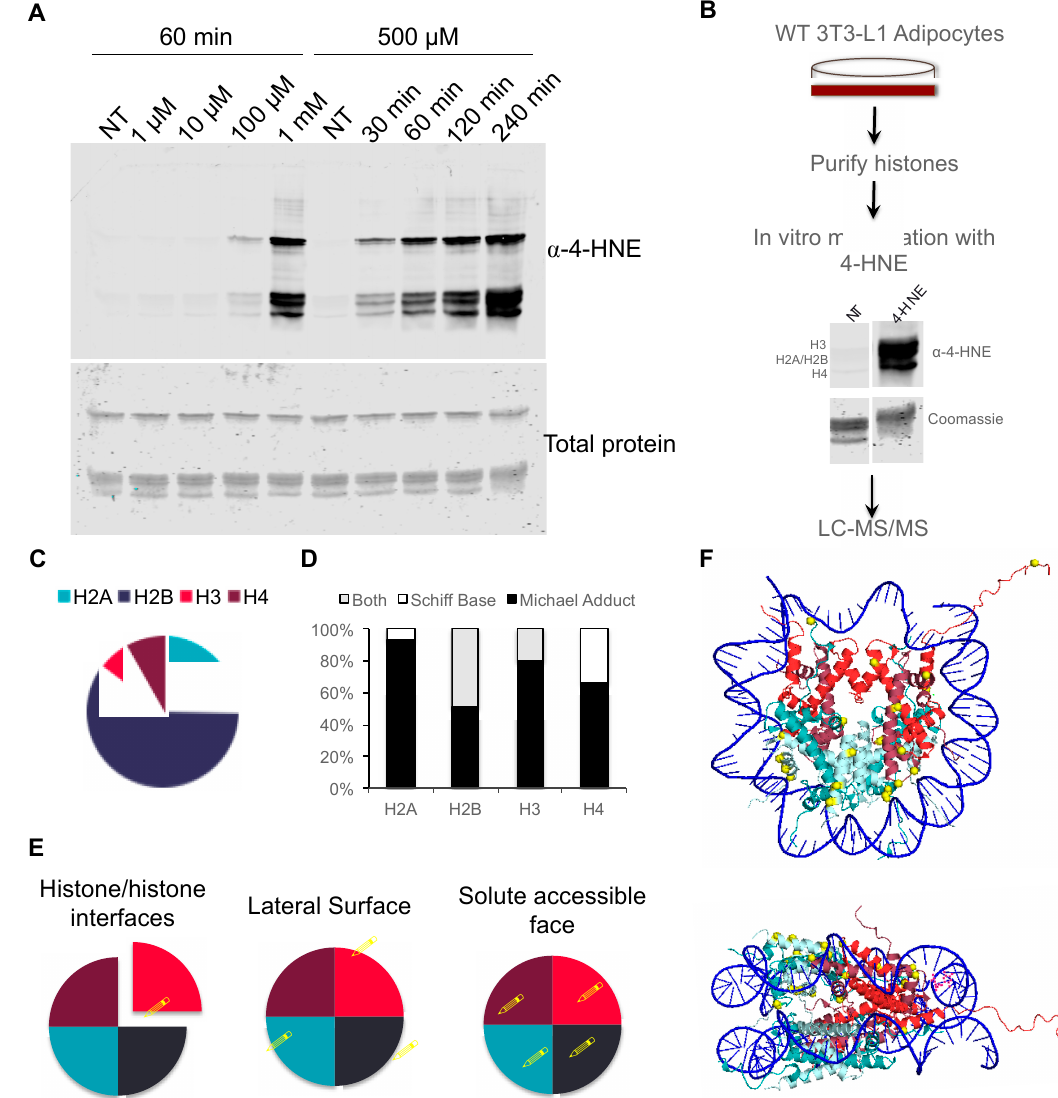
Figure 3. Proteomic evaluation of in vitro 4-HNE-modified core histones. ( A ) In vitro modification of purified histones with 4-HNE. Titration of 4-HNE concentration (left) and reaction time (right). ( B ) Flow diagram of LC–MS/MS workflow for proteomic analysis of modified sites. ( C ) Pie chart of distribution of 4-HNE modification across the core histones ( D ) Ratio of Michael adducts and Schiff bases identified on in vitro-modified histones. ( E ) Depiction of the categories of localization of identified sites on the nucleosome structure. ( F ) Ribbon diagram of the nucleosome (structure generated from pdb1aoi). 4-HNE-modified residues are shown in yellow.